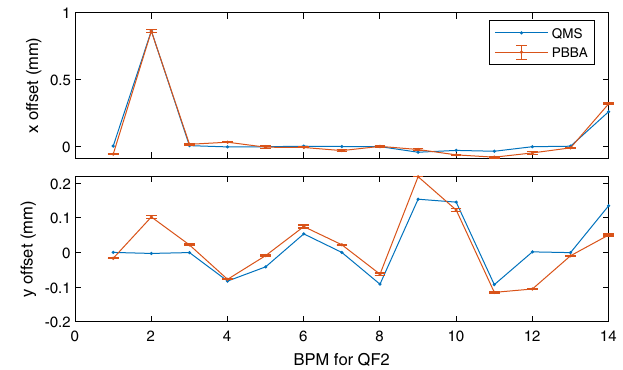
FIG. 10. The quadrupole center offsets found by the PBBA method are compared to the target values for the SPEAR example. Error bars are by standard deviations of 10 random seeds, with BPM noise sigma of 1 μ m.